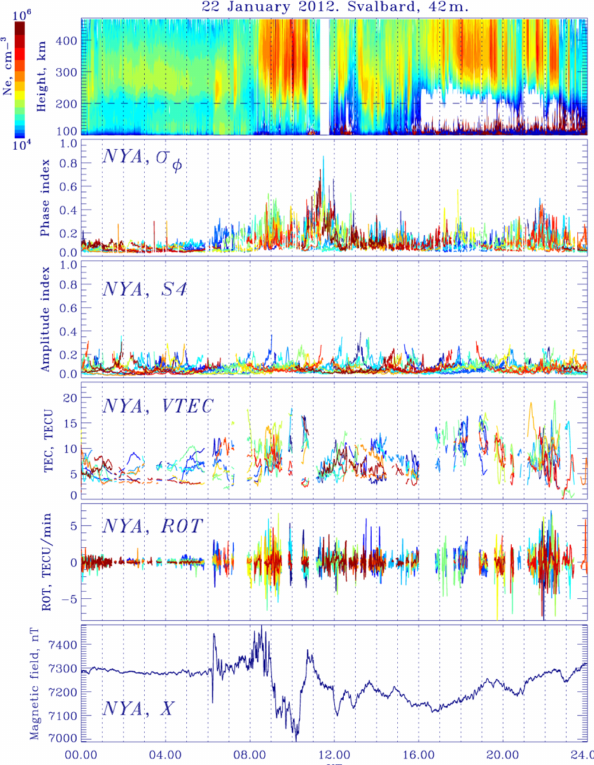
Figure 5. Solar wind speed V (kilometres per second), solar wind density N (cubic centimetres), magnitude of the IMF (interplane- tary magnetic field) B (nanoteslas), B z component (nanoteslas) of IMF according to the OMNIWeb database, SYM-H index (nanotes- las), and AE index (nanoteslas) for 22 January 2012.